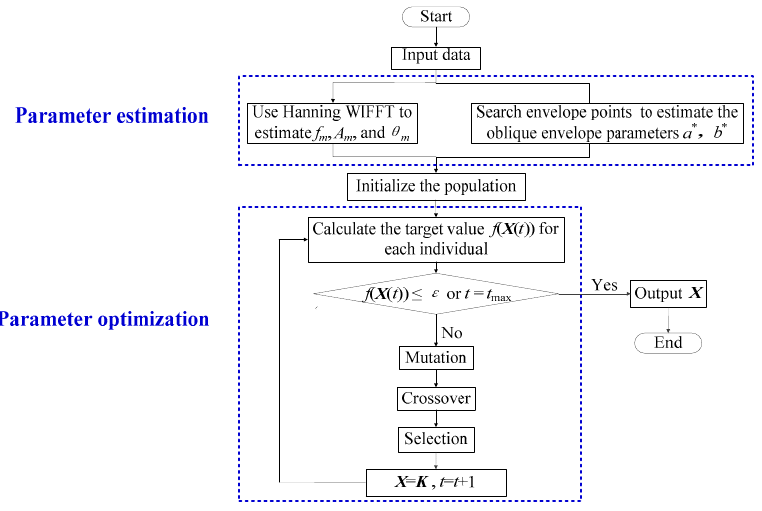
Figure 2. The flow chart of the improved method based on WIFFT and DE algorithm.